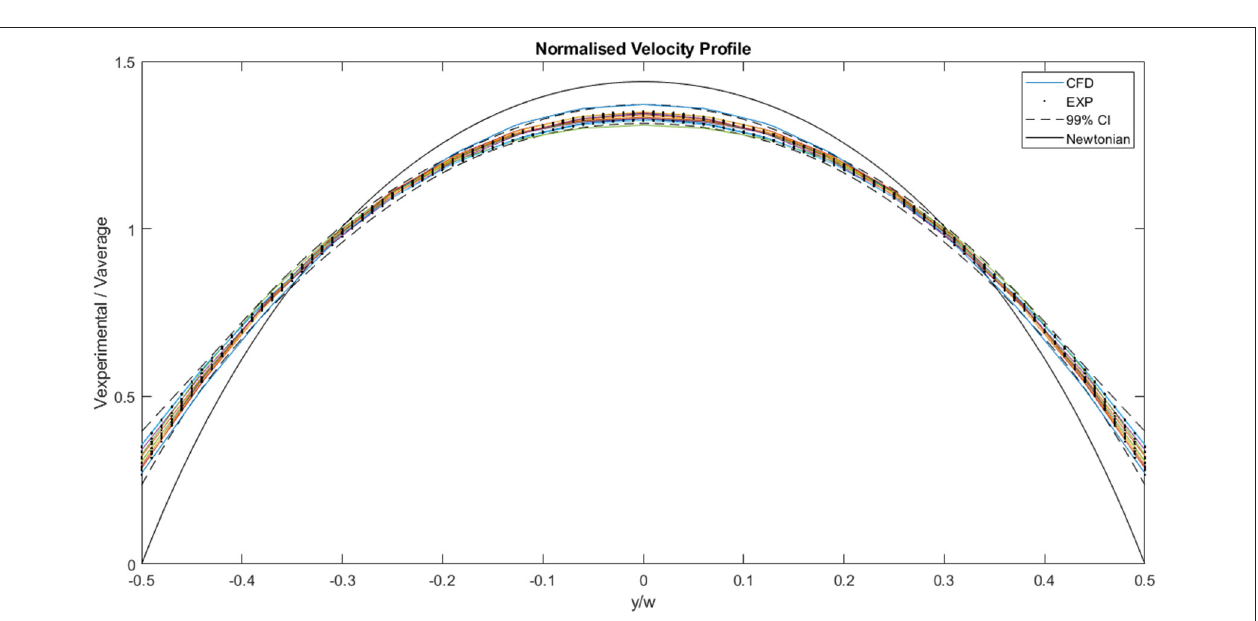
the overall block. The same mass flow rate is specified at